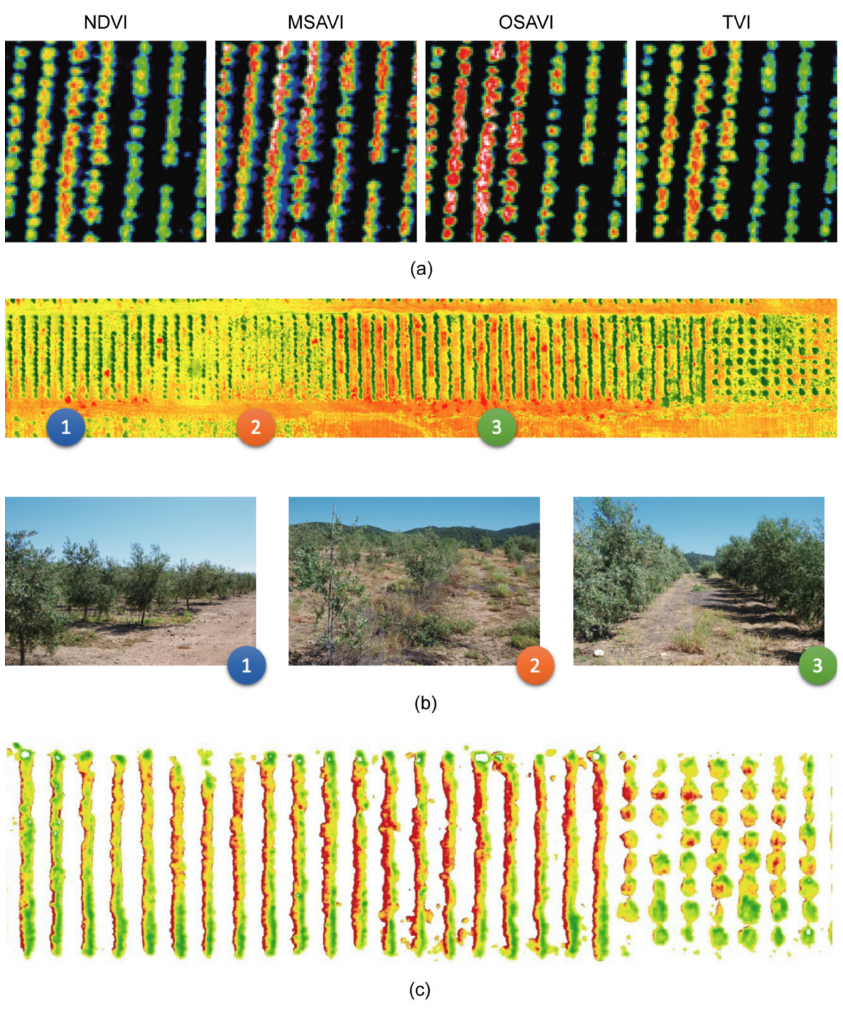
Figure 7. Examples of student results: ( a ) comparison of results of di ff erent vegetation indices, ( b ) analysis of the relationship between thermographic UAV and field inspection, and ( c ) a water stress map. Table 5. Results of the student satisfaction survey (Values in the range between 0 and